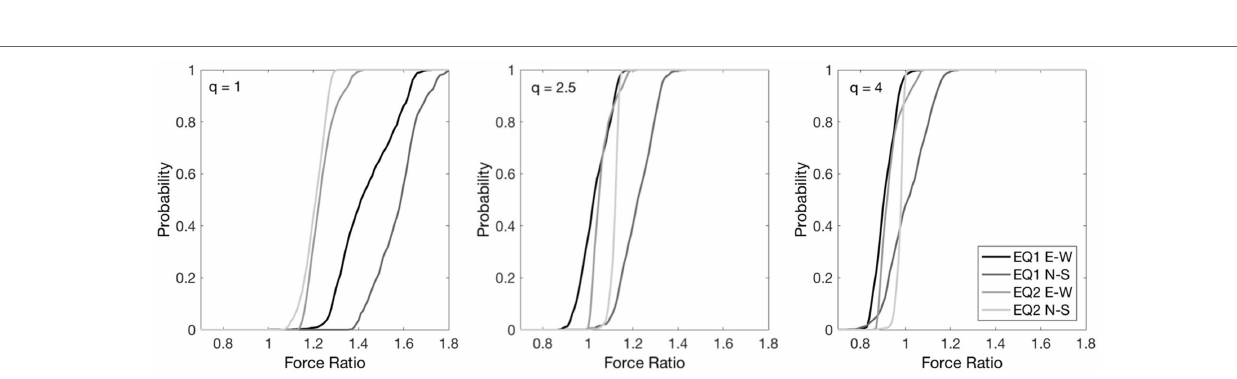
FigUre 9 | Influence of the behavior factor and of the seismic input on the response of the reference case: roof displacement ratio between the cases with and without the hoist load.